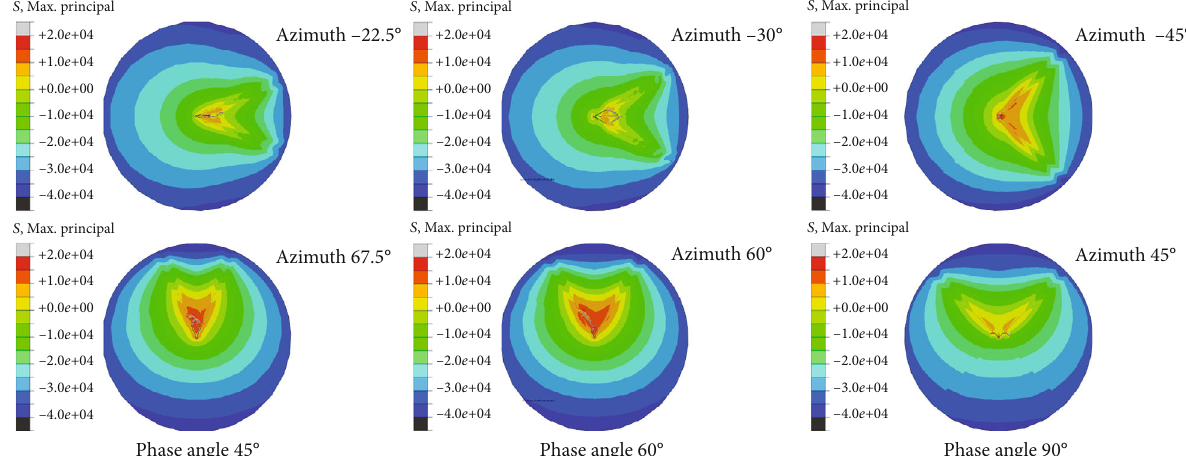
Figure 9: Simulation results of fracture morphology in interference stress fi eld.